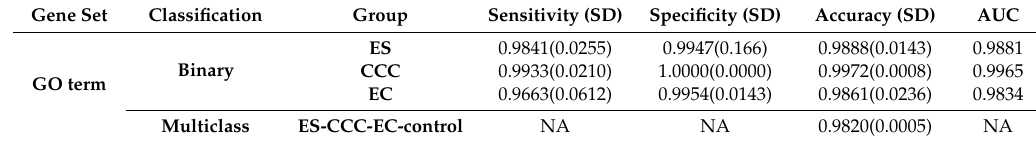
Figure 3. Heatmaps and dendrogram for the three diseases. The dendrogram (left side of the heatmap) shows the relationship of the three diseases. When displayed on the heatmap, each of the three diseases computed through the Gene Ontology (GO) term gene sets show a distinct pattern, however, the patterns are more similar between CCC and EC. Table 3. Accuracies of the binary and multiclass classification and prediction by machine